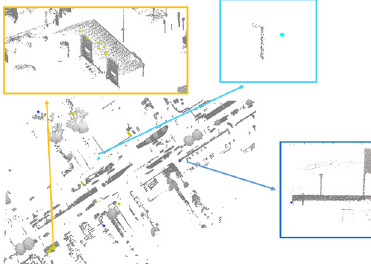
Table 2. Analyses of map points without a corresponding MLS segment.